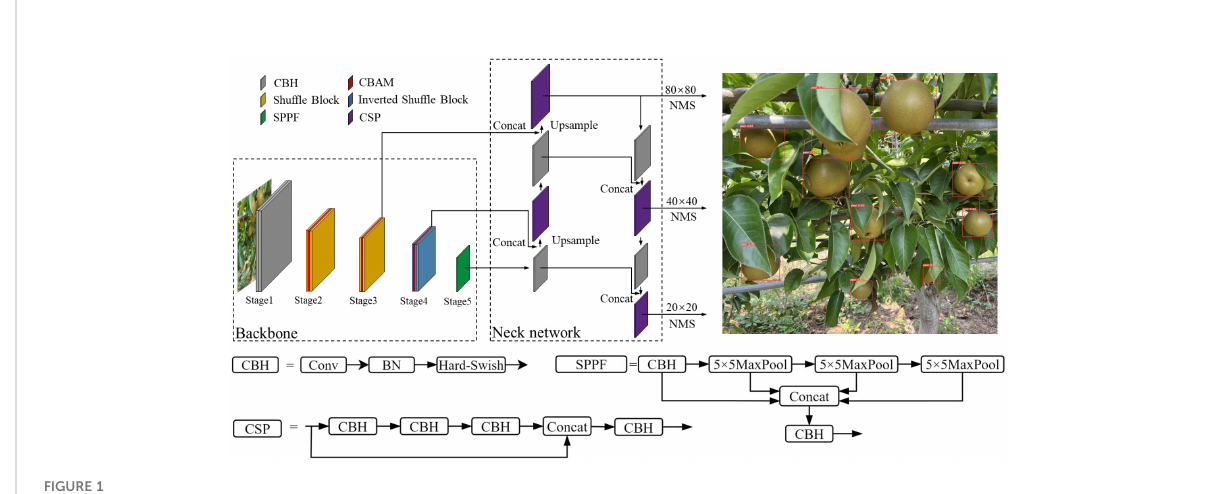
FIGURE 1 The network structure of